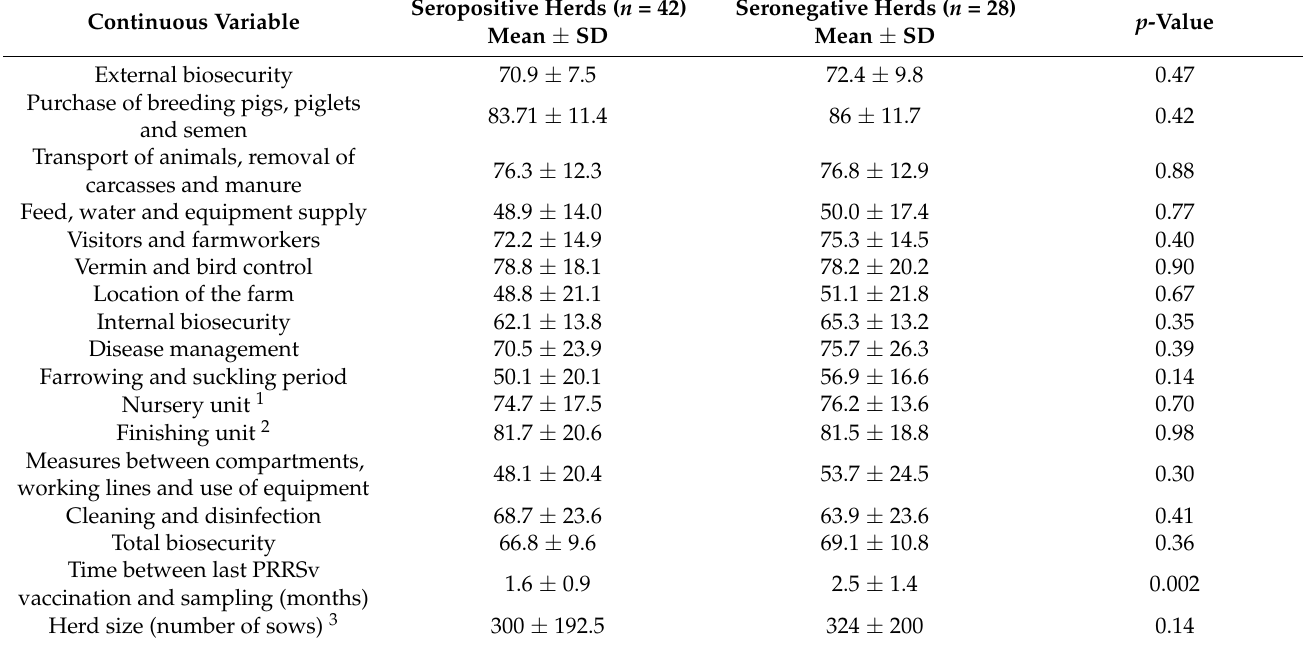
Table 4. Unpaired t-test/Mann–Whitney U test comparing the differences in mean/median values of continuous variables between “seronegative” (herds with at least one ELISA 1 (IDEXX PRRS X3) seronegative sow) and “seropositive” (herds without any ELISA 1 seronegative sow) herds. Results are shown as the mean ± standard deviation (SD) or the median ± interquartile range (IQR) value for the continuous variable in the seropositive ( n = 42) and seronegative ( n = 28) herds. Differences with a p-value < 0.05 are considered to be